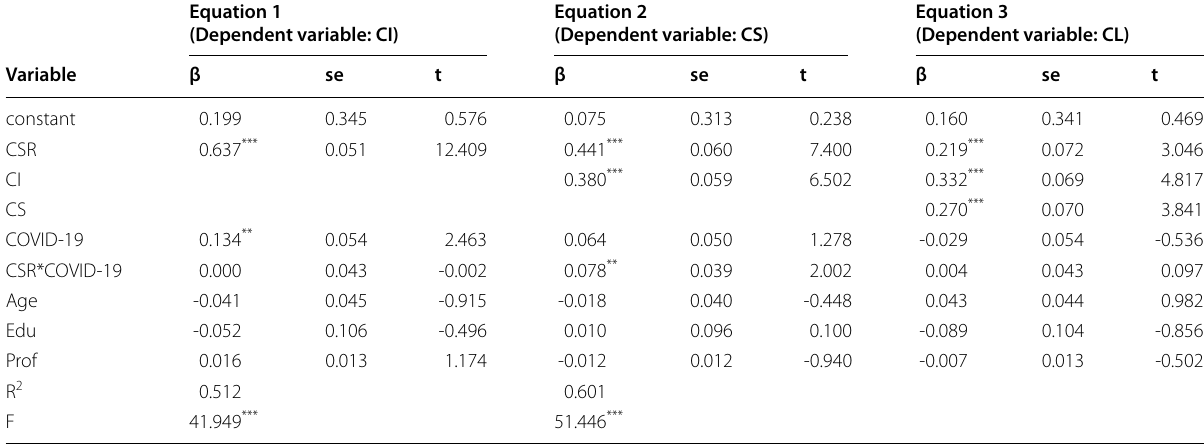
Table 6 Moderated mediation model test